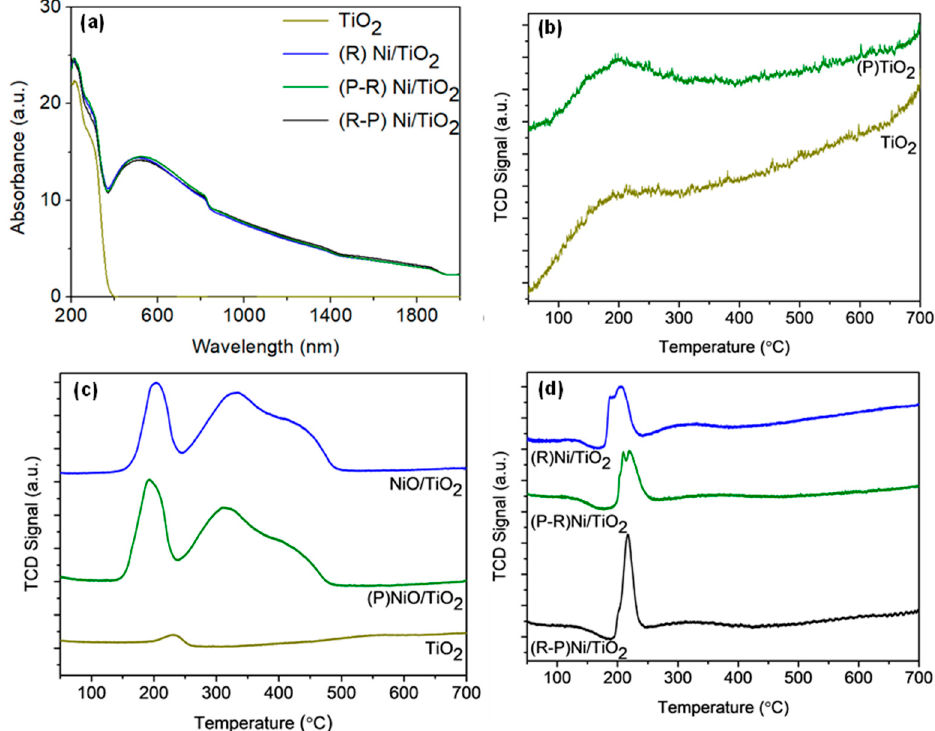
Figure 2. ( a ) UV-vis-NIR absorbance of TiO 2 and pretreated Ni/TiO 2 ; ( b ) CO 2 -TPD of TiO 2 and plasma-treated TiO 2 ((P)TiO 2 ); H 2 -TPR of ( c ) TiO 2 and NiO/TiO 2 and ( d ) pretreated Ni/TiO 2 . R = reduced/passivated, P = plasma treated.